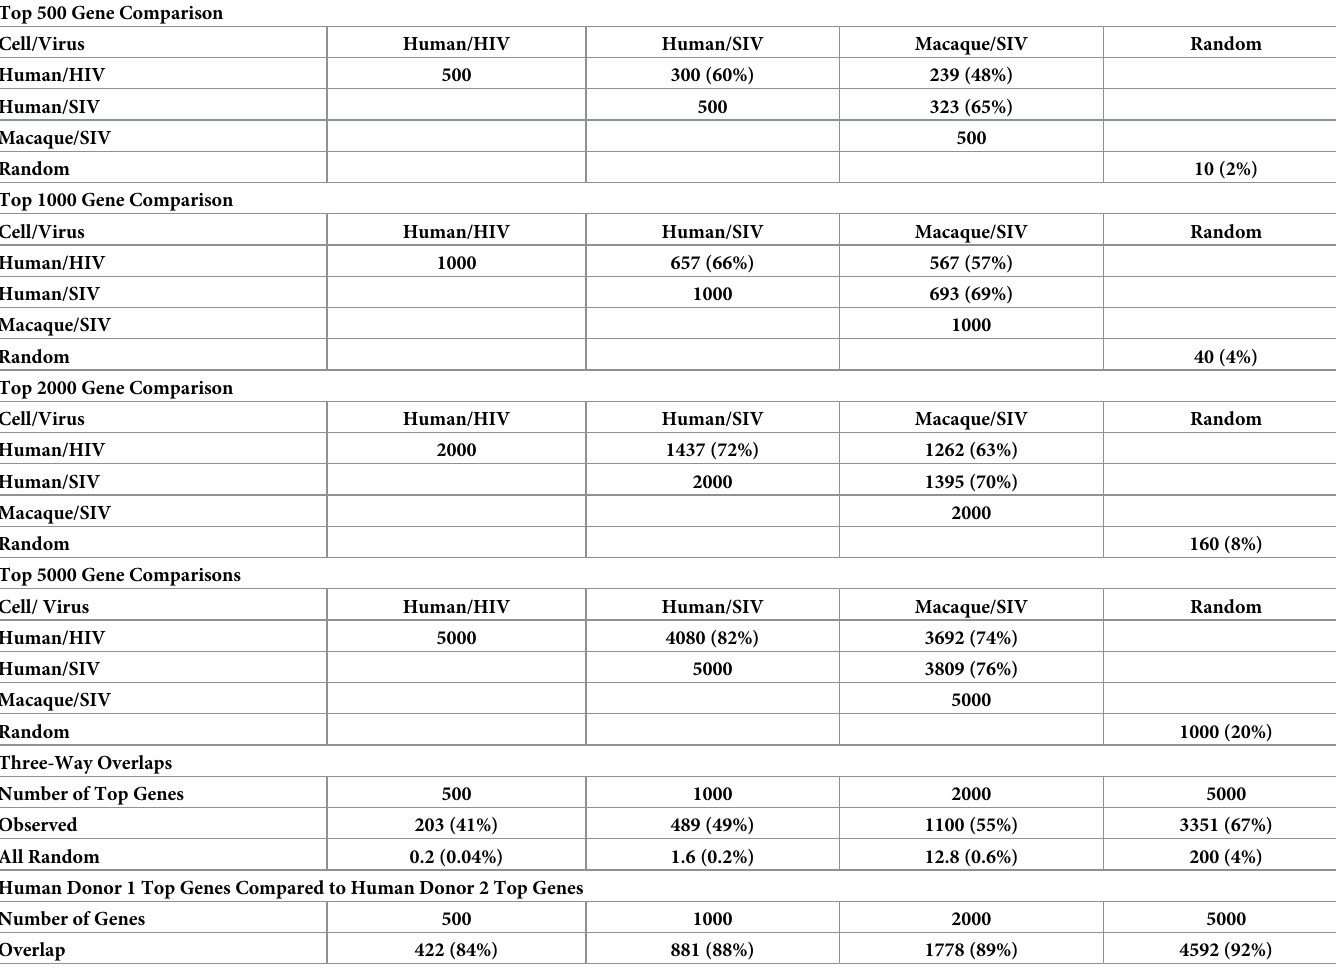
Table 2. Comparison of the genes that are the most frequent HIV and SIV integration